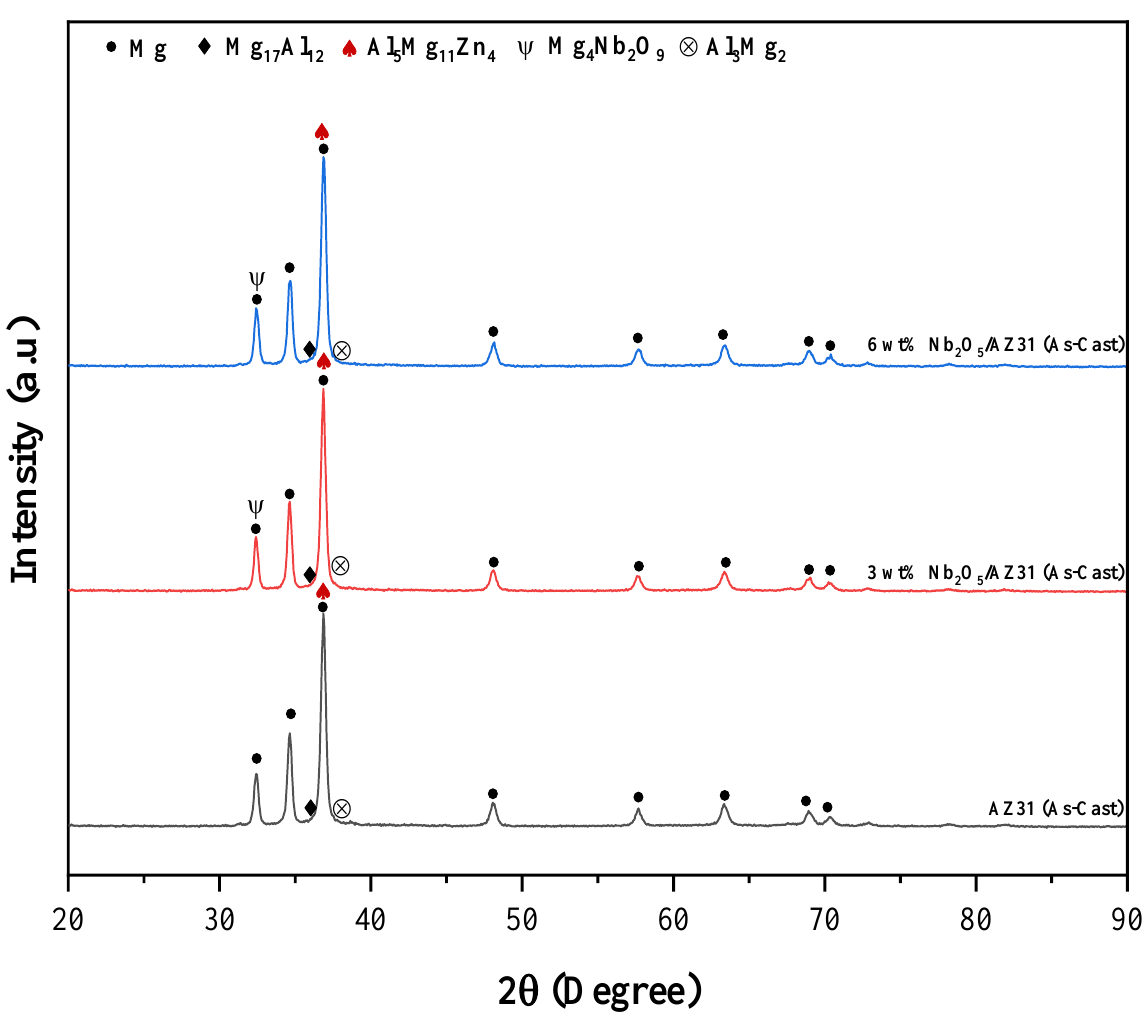
Table 2. Shows phase quantification and crystal structure.